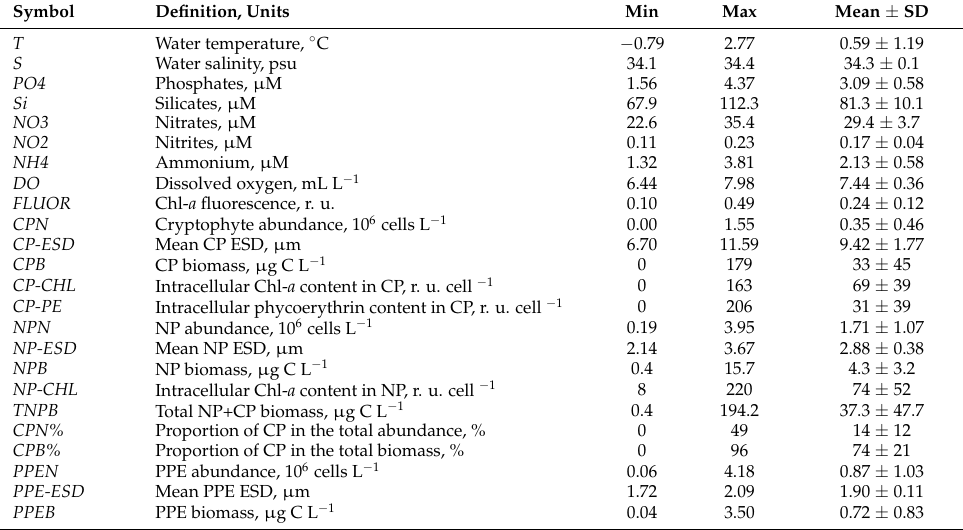
Table 1. Symbols of variables used in this study with their definitions, units, and descriptive statistics (n = 39). R. u. is relative units, CP is cryptophyte, NP is nanoplankton, PPE is photosynthetic picoeukaryotes, ESD is equivalent spherical diameter, SD is standard deviation.